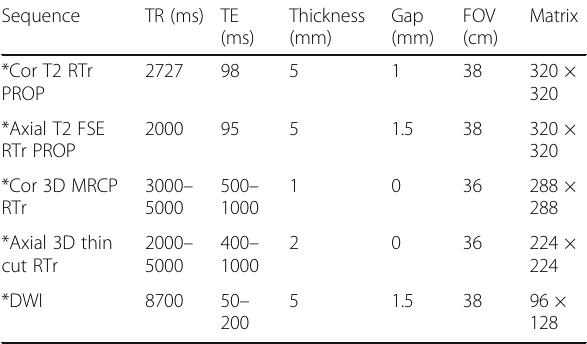
Table 1 Summary of magnetic resonance cholangiopancreatography imaging parameters